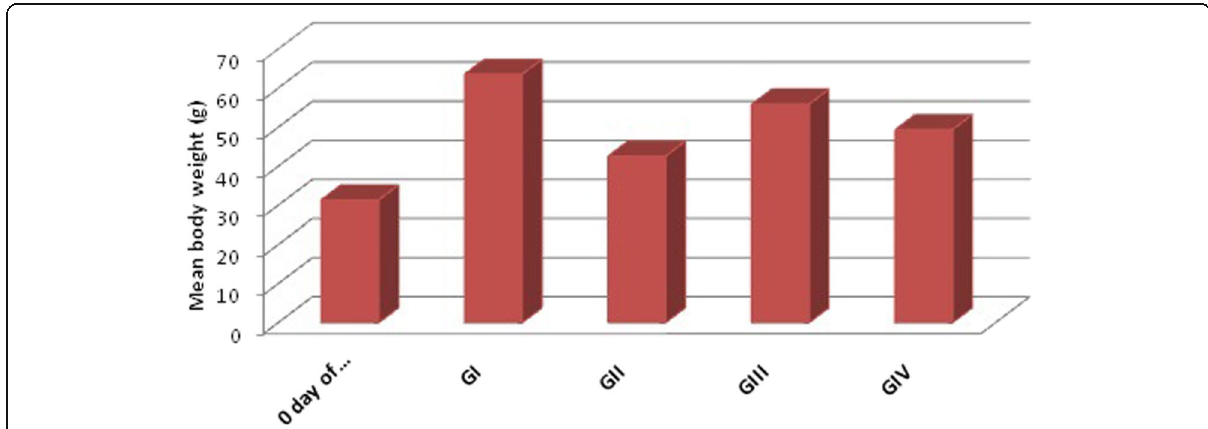
Fig. 1 Histogram showing the maternal body weight for control and treated